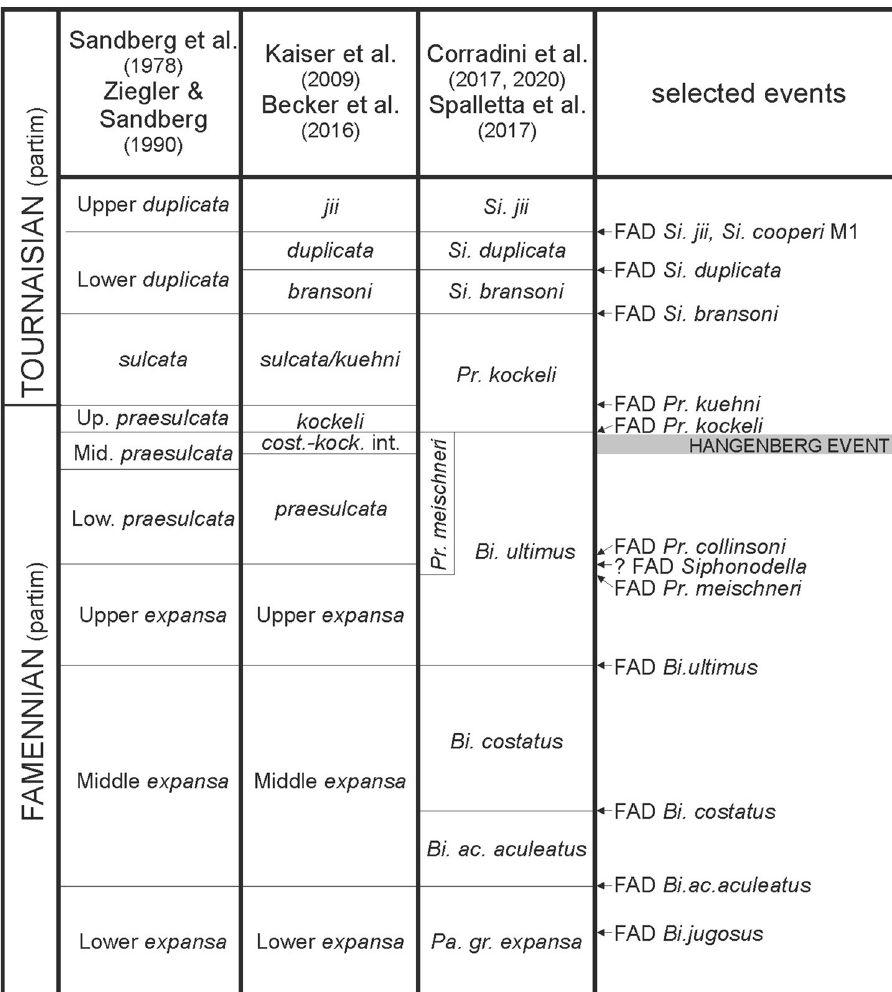
Figure 4. Conodont zonation applied in this paper (third column) compared with previous zonations and selected bioevents. Biostratigraphy is based on 26,28–31,92,93 . Thickness of biozones is calibrated according to their length, as estimated in the Devonian and Carboniferous chapter of The Geologic Time Scale 2012 94,95 .